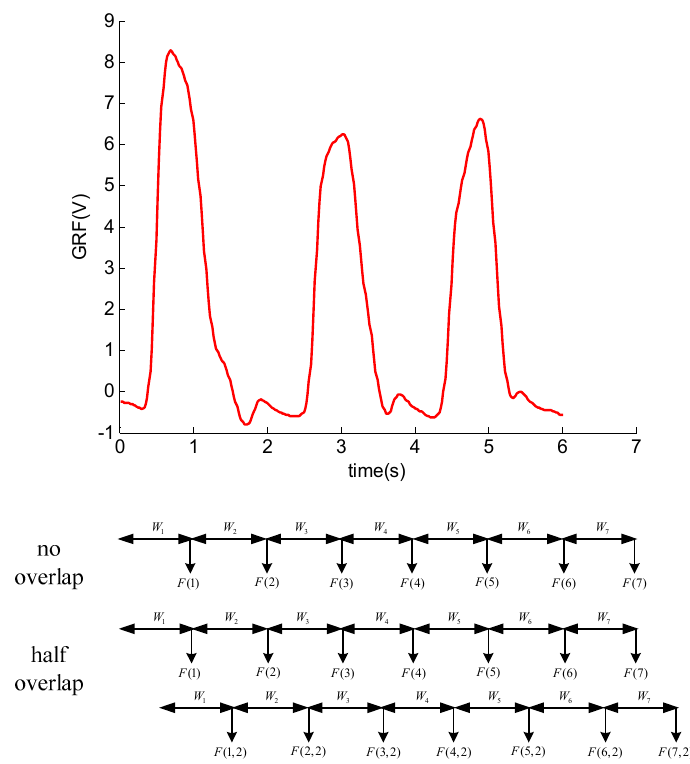
Figure 7. Windowing and feature extraction for a time series of observations. W ( T ) is the window of the T interval and F ( T ) is the corresponding output features. In the case of half overlap, there is a feature set output at each half window, F ( T, 2) is the features produced due to overlap.